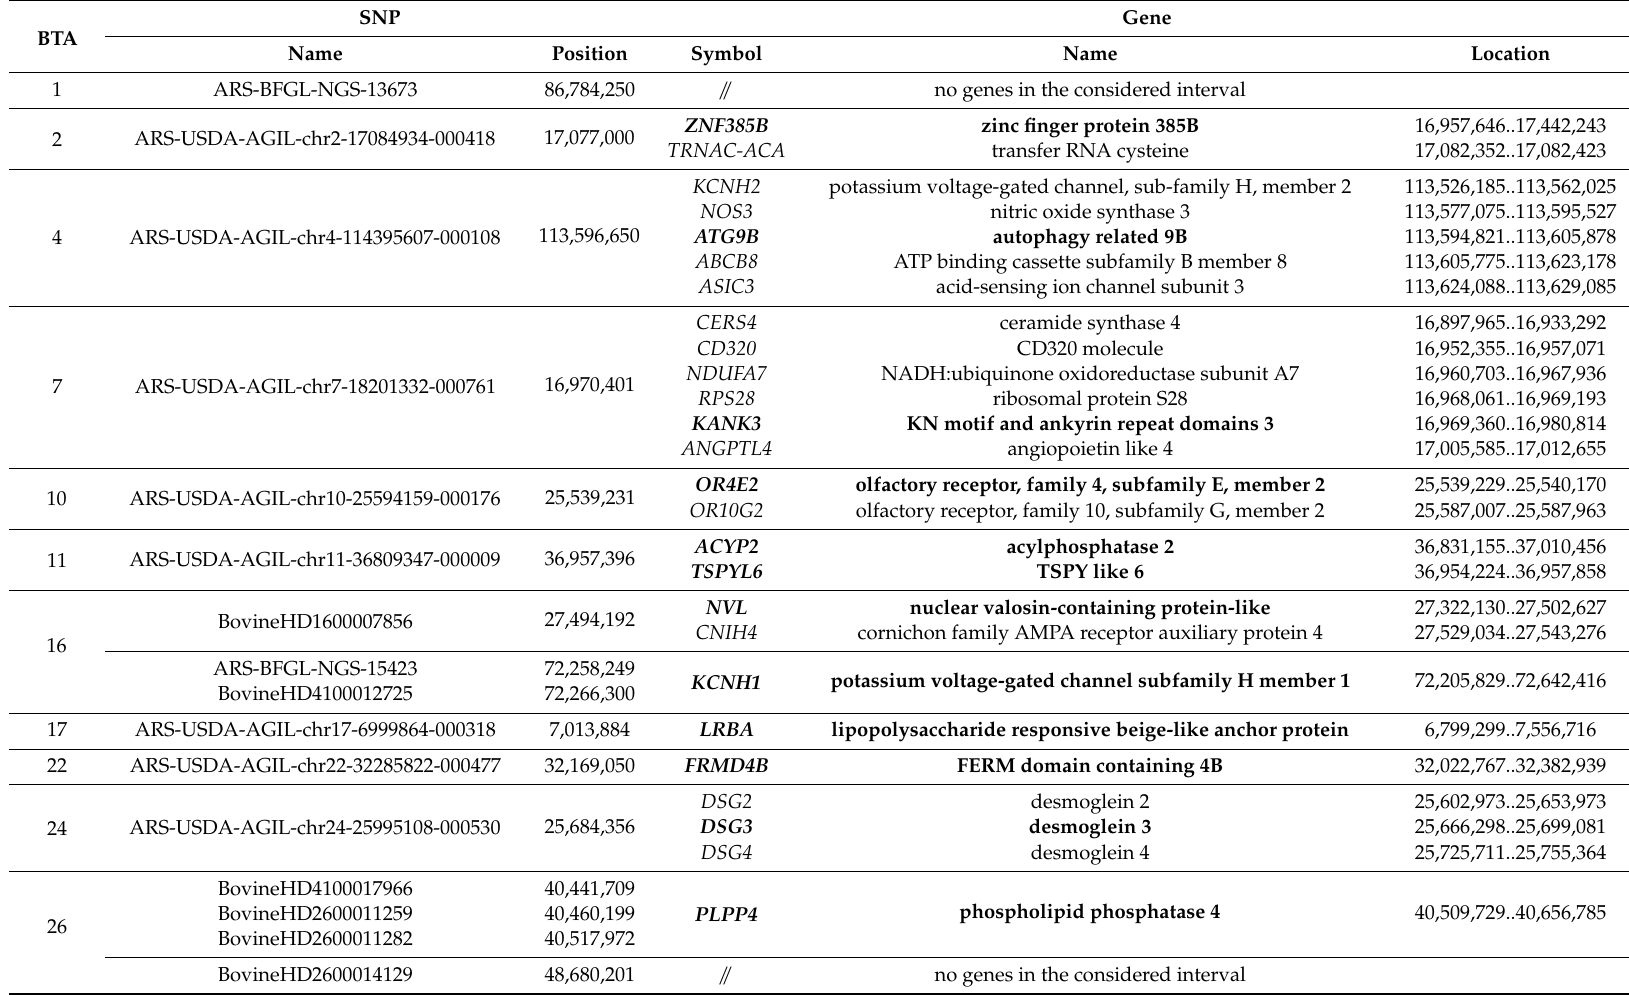
Table 3. Genes near the SNPs associated to macroglossia. The genes including a marker are in